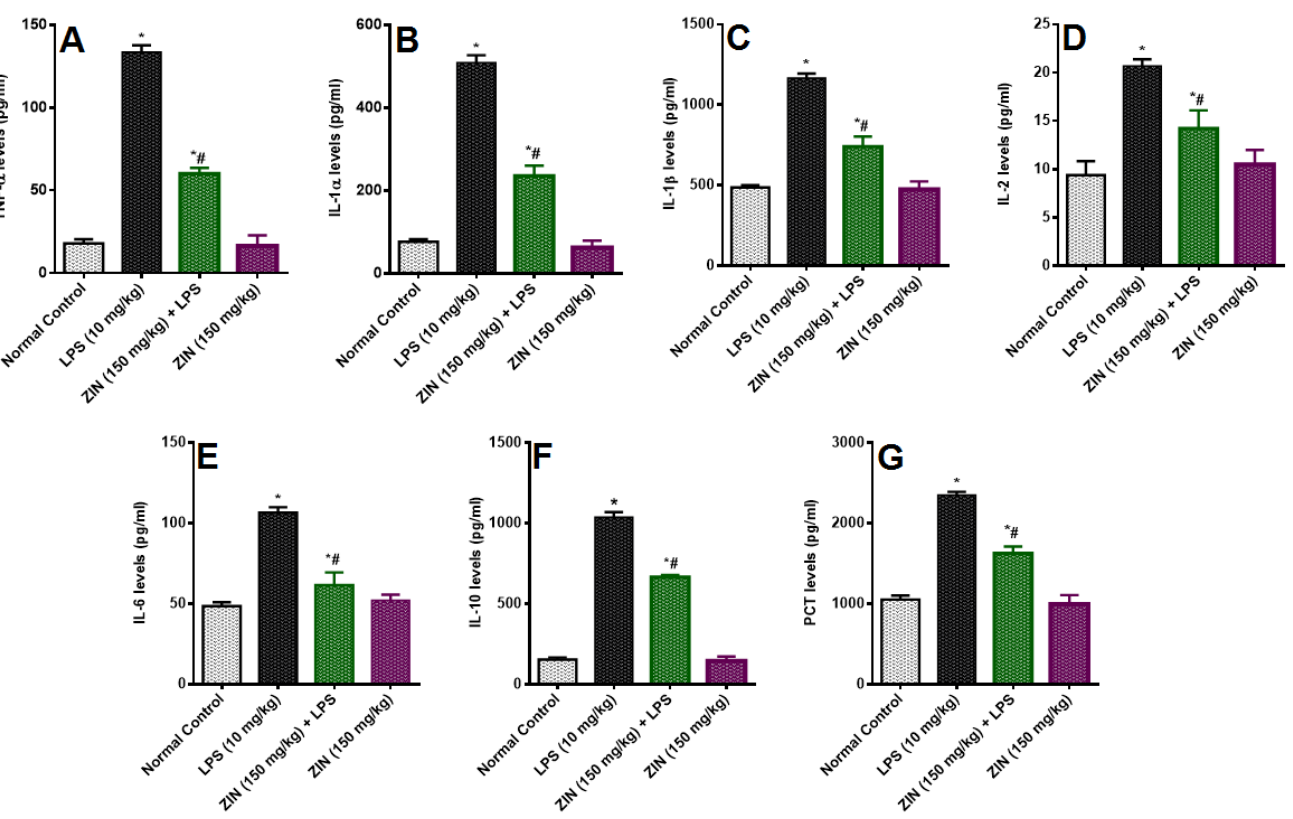
Figure 7. Effect of zingerone (ZIN) on LPS-induced Proinflammatory cytokines and sepsis biomarker PCT (pg/mL). ( A ) TNF-α, ( B ) IL-1α, ( C ) IL-2, ( D ) IL-6, ( E ) IL-8, ( F ) IL-10, and ( G ) procalcitonin (PCT). Results are represented as mean ± SEM of six rats / group. * p < 0.05 vs. control; # p < 0.05 vs. LPS group.